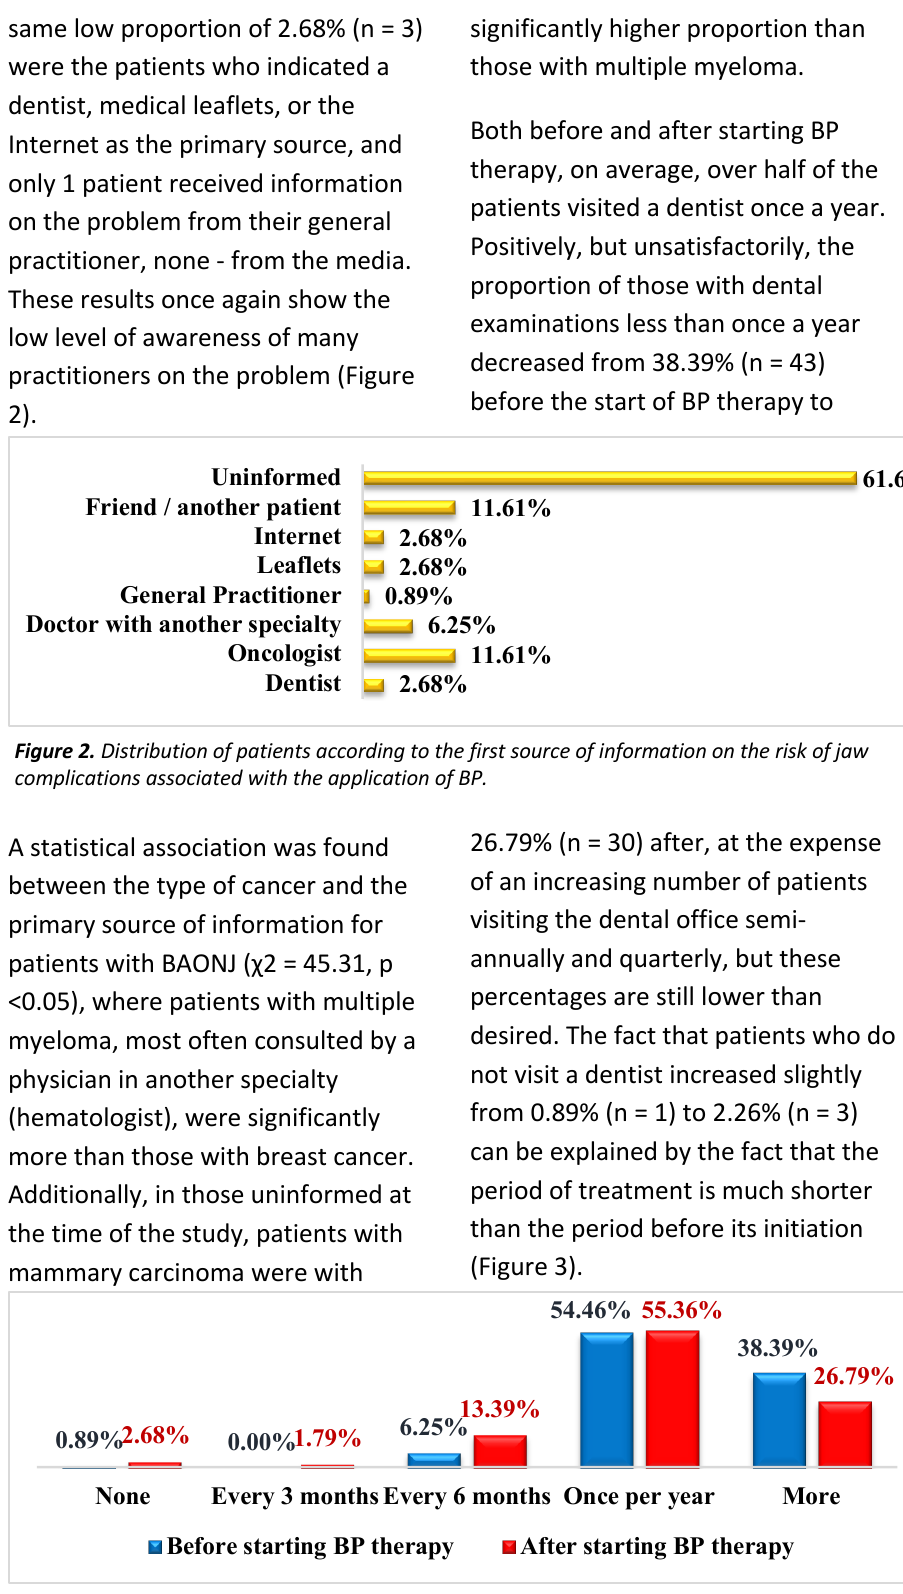
Figure 3. Distribution of the frequency of visits to the dentist before and after the start of BP